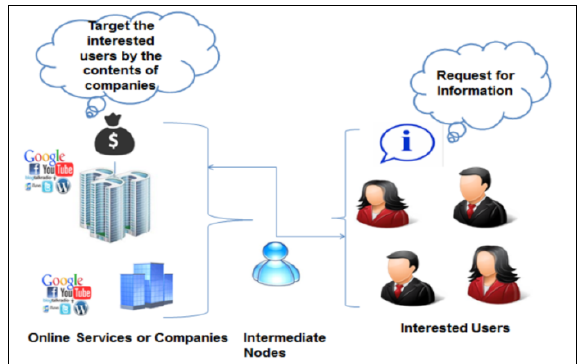
Figure.1. Business-Customer relationship